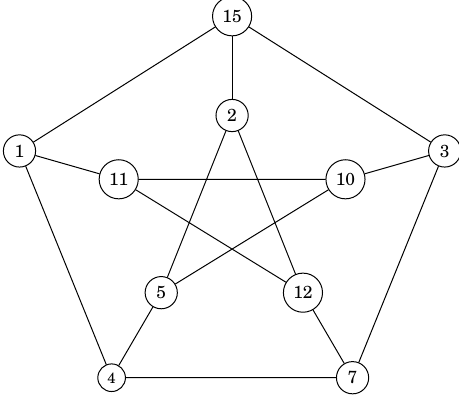
Figure 2: A harmonious